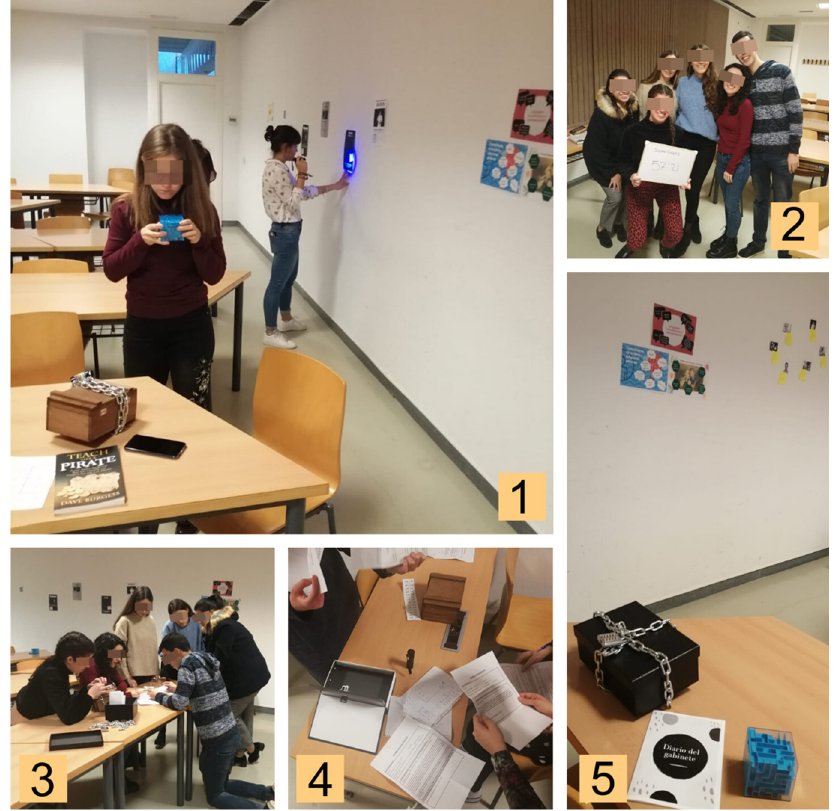
Figure 1. The escape room design and implementation. ( 1 ) Students distributed around the room looking for clues to exit; ( 2 ) final photo after the escape room; ( 3 , 4 ) students working cooperatively to solve challenges of the escape room; ( 5 ) some of the elements of the escape room.